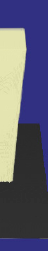
Figure 8. Three-dimensional lithography profiles of a cross-shaped mask with perpendicular incidence by using a comprehensive lithography simulation: exposure time = 250 s, development time = 12 min. The first step PEB condition was 65 °C/12 min and the second step PEB condition was 95 °C/40